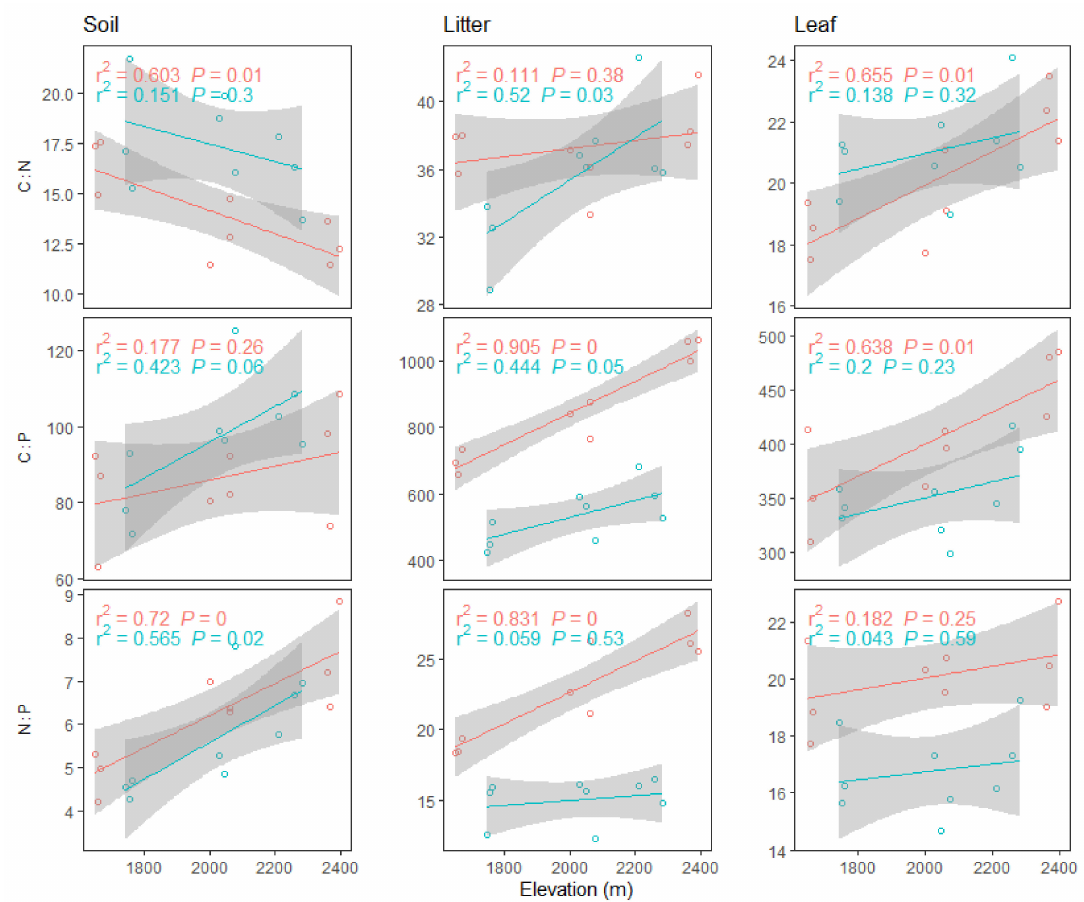
Figure 3. Changes in soil, litter, and leaf C:N:P ratios with elevation for two origins of Larix principis-rupprechtii forests (red and blue are planted and natural, respectively). Lines and shade represent fitted regressions and corresponding 95% confidence